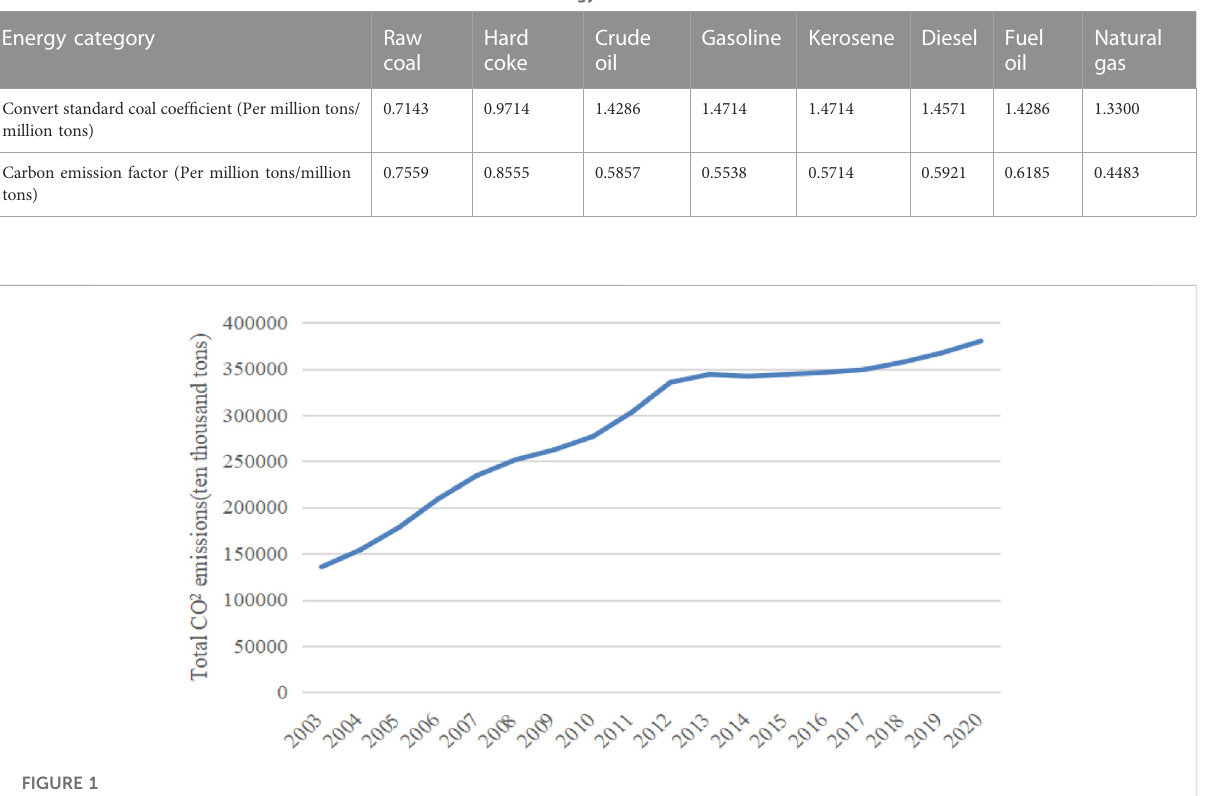
TABLE 1 Standard coal coef fi cient and carbon emission coef fi cient of energy conversion.